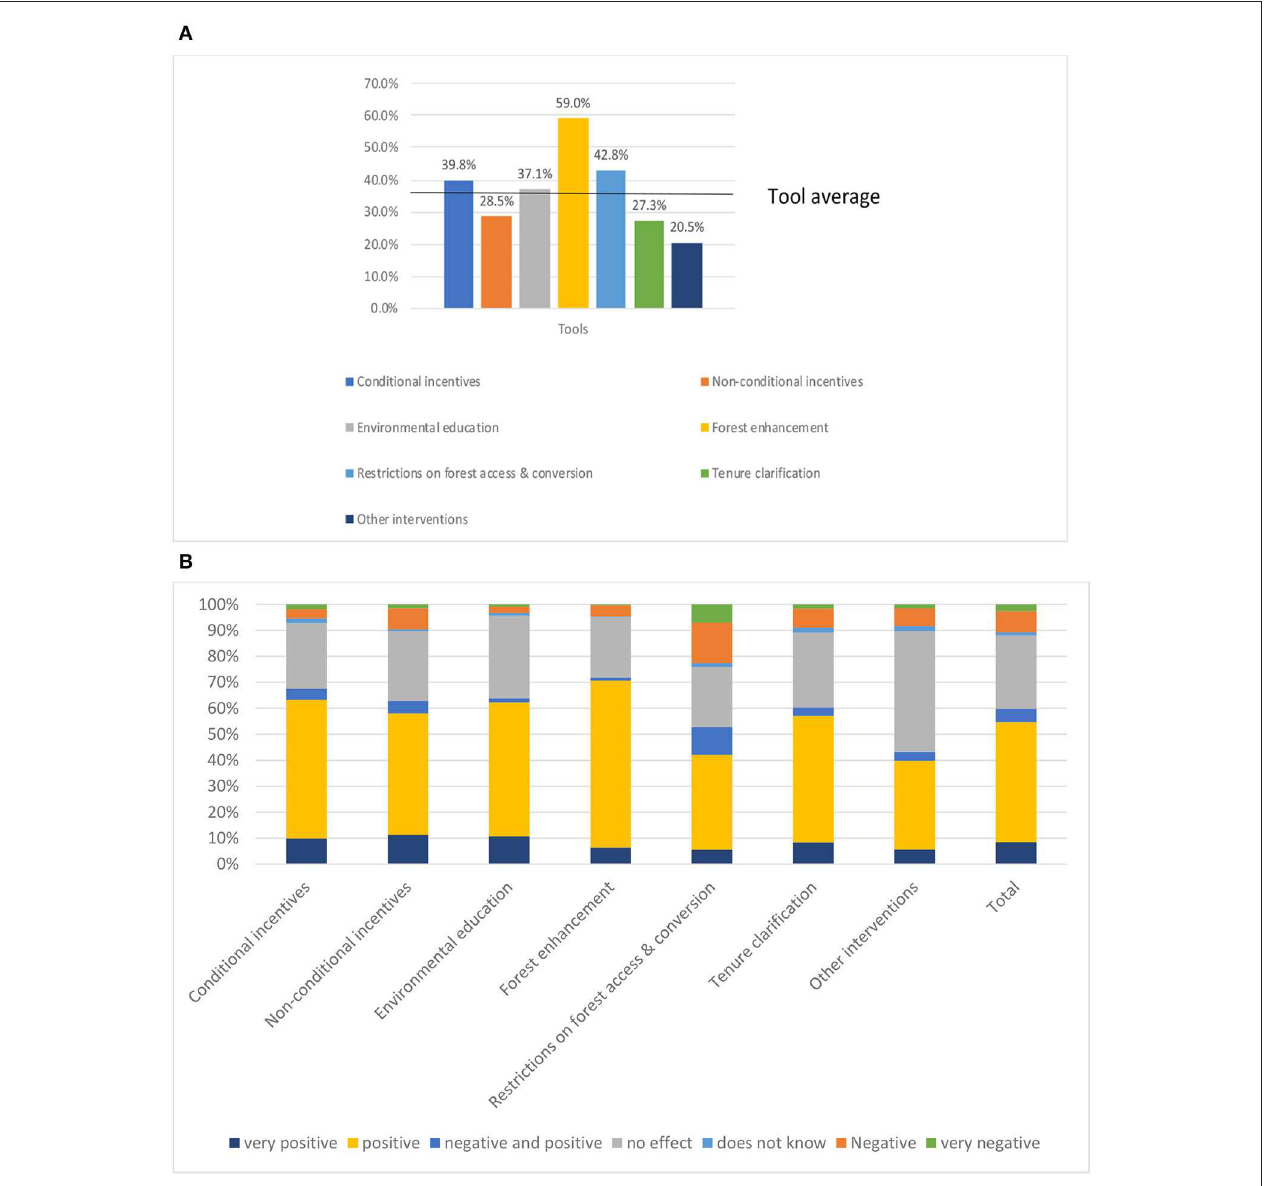
FIGURE 8 | Household-reported REDD + partial tool impacts on land use and well-being: did the treatment component affect households? (A) Land use. (B) Well-being. Includes only cases where the household is actually involved in the intervention (“involved” = “yes”). Source: GCS-REDD M2 data, household surveys,